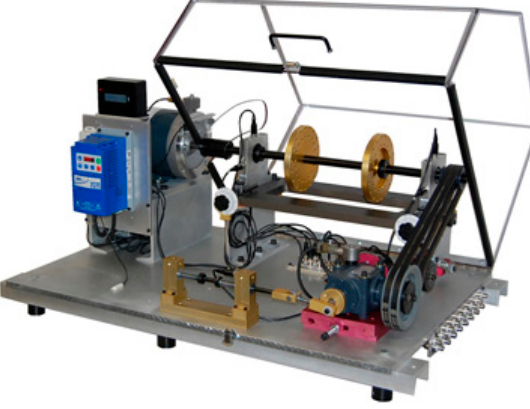
Figure 6. The test rig of the outer fault bearing.